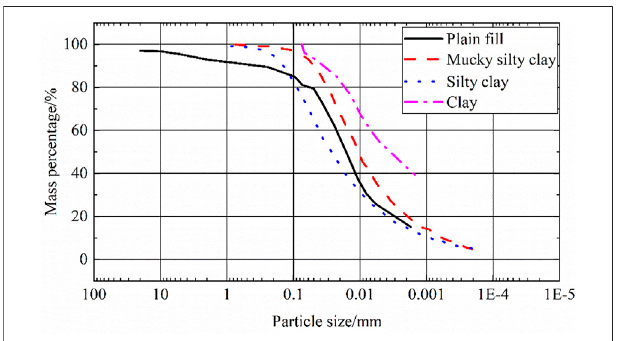
FIGURE 1 | Cumulative curve of soil particle size